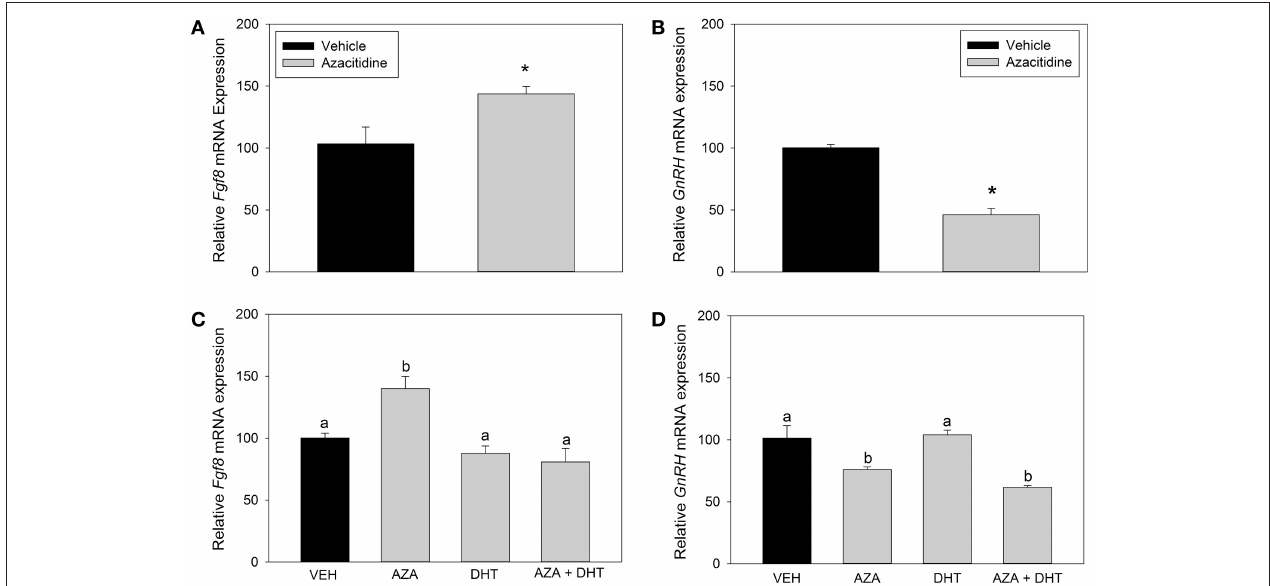
FIGURE 5 | RT-qPCR for Fgf8 and GnRH mRNA in GT1-7 neurons treated with vehicle ( n = 4 ) or 1 µ M AZA ( n = 4 ) for 72h. AZA-treatment significantly increased Fgf8 mRNA expression ( p < 0.05 ) (A) and reduced GnRH mRNA levels ( p < 0.0001 ) (B) . RT-qPCR for Fgf8 and GnRH mRNA expression in GT1-7 neurons treated with vehicle or AZA for 3 days and vehicle or 100nM DHT for 4h (C,D) . One-way ANOVA showed a significant treatment effect on Fgf8 mRNA levels [ F (3 , 15) = 10.5 , p < 0.005 ] (C) . Post hoc analysis showed that AZA increased Fgf8 mRNA levels compared to vehicle ( n = 4 ; p < 0.01 ), DHT ( n = 4 ; p < 0.005 ) and AZA + DHT ( n = 4 ; p < 0.005 ) treatment groups. One-way ANOVA showed a significant treatment effect on GnRH mRNA levels [ F (3 , 15) = 13.7 , p < 0.005 ] (D) . Post hoc analysis showed that compared to vehicle and DHT treatment groups, AZA treatment significantly reduced GnRH mRNA levels ( n = 4 ; p < 0.05 ). GnRH mRNA levels were significantly lower in GT1-7 neurons treated with AZA + DHT ( n = 4 ; p < 0.005 ). DHT treatment did not effect GnRH mRNA levels, nor was DHT able to prevent AZA-dependent downregulation of GnRH mRNA levels. * or different letter indicate p < 0.05